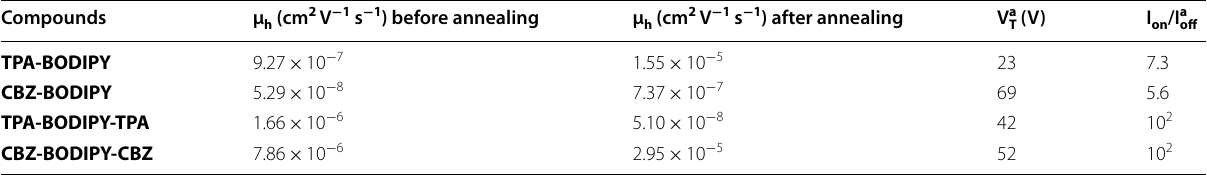
Table 2 Organic thin-film transistor characteristics of BODIPY dyads and